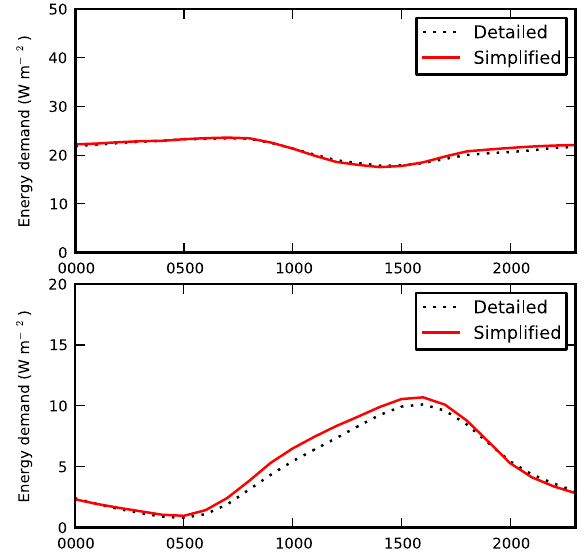
33 Fig. 5. Monthly-averaged diurnal cycles of heating energy demand between 16 January and 15 February (top) and cooling energy de- mand between 1 July and 30 July (bottom) per unit of floor area calculated by the simplified and the detailed EnergyPlus models of a Haussmannian building in